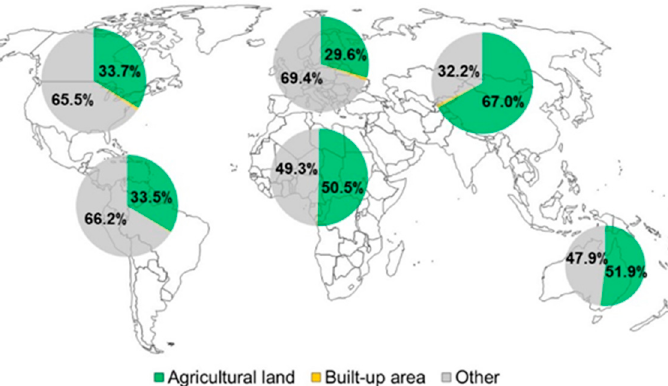
Figure 1. The increasing competition for land use. Habitable land use in 2018. The surface data come from FAO (www.fao.org/faostat/en/#data, accessed on 27 November 2021). The values were calculated for North America, South and Central America, Europe, Africa, Asia and Oceania, relative to the total habitable land area, which was the sum of agricultural lands, built-up areas, and non- aquatic forests and shrub areas that are not regularly flooded. The “Other” section contains forests and shrubs that are non-aquatic or regularly flooded. The “Built-up area” section represents 1% or less of the habitable land use for each geographic region.